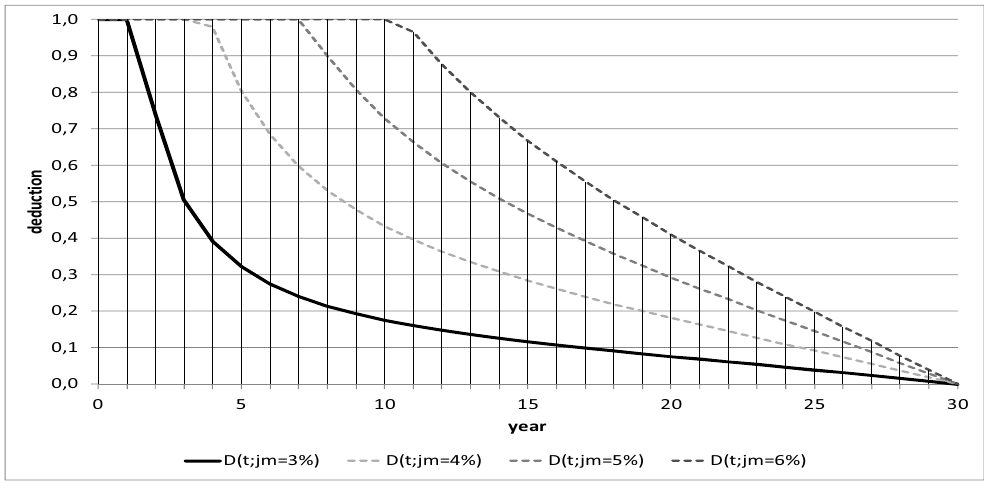
Fig. 4A. Comparative deduction D ( t ; 1) for different values of the yield average rate, j m .